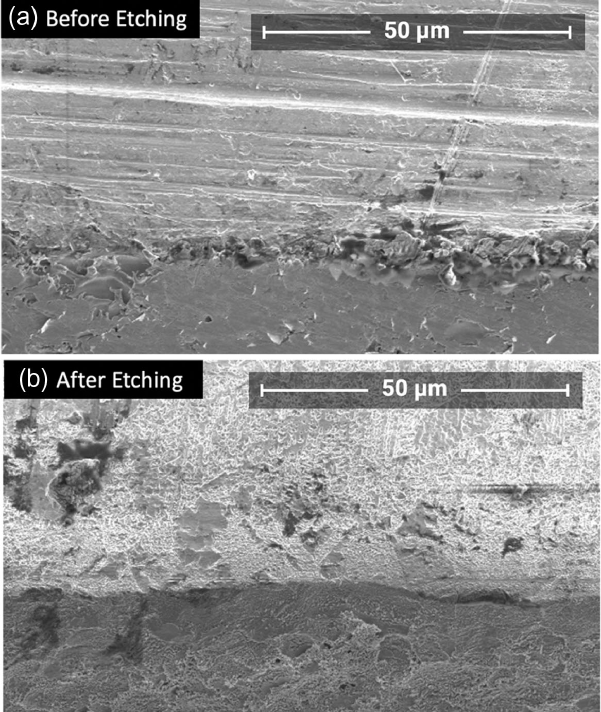
28. ( Angled View ) Scanning electron microscope images of the plate edge from before (top) and after (bottom) Citranox Fig. 26(d). Four baths were chose as the optimal number to remove sharp features while minimizing excessive pitting.